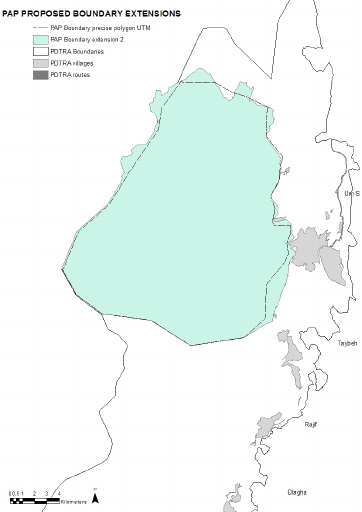
Figure 8: proposed scenario for an extension equal to 10% of the